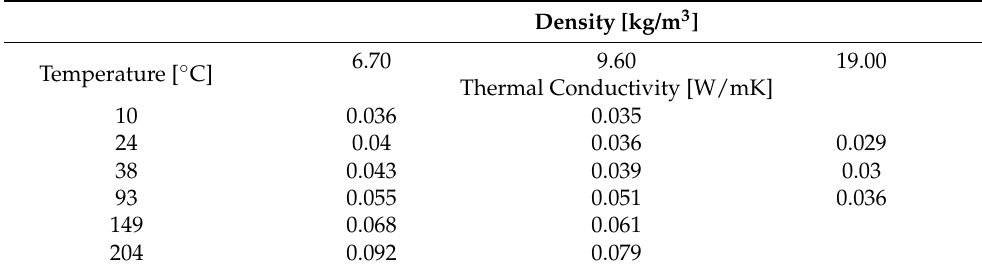
Table 3. The declared thermal